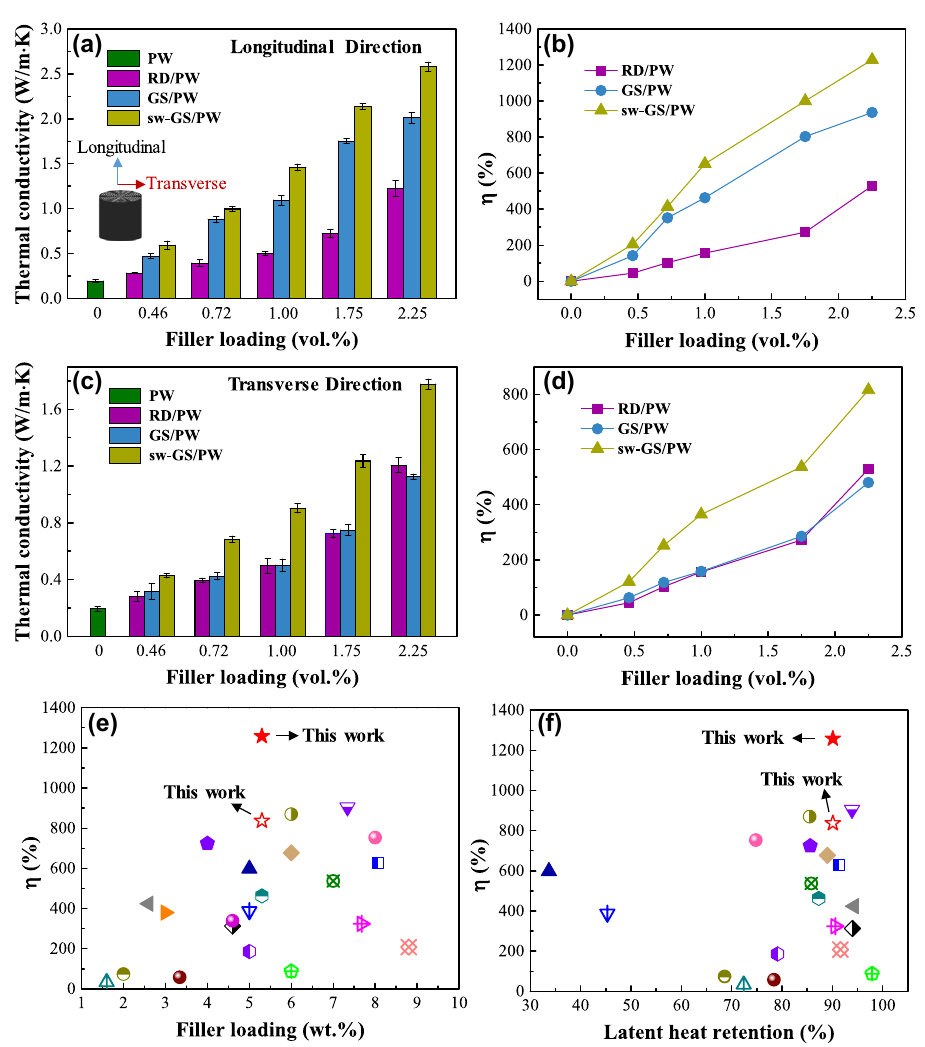
Fig. 4 a Thermal conductivity and b enhancement in longitudinal (cross‑plane) direction of PW composites; inset in (a) shows the directions of thermal conductivity for PW composites. c Thermal conductivity and d enhancement in transverse (in‑plane) direction of PW composites. e Comparison of thermal conductivity enhancement ( η ) of sw‑GS/PW‑2.25 with those of other reported PCCs having low filler loading (< 10 wt.%) [15, 17, 19, 34, 47–62]. f Comparisons of thermal conductivity enhancement ( η ) and latent heat retention of sw‑GS/PW‑2.25 with those of other reported PCCs with relatively low filler loading [15, 17, 19, 34, 47, 48,